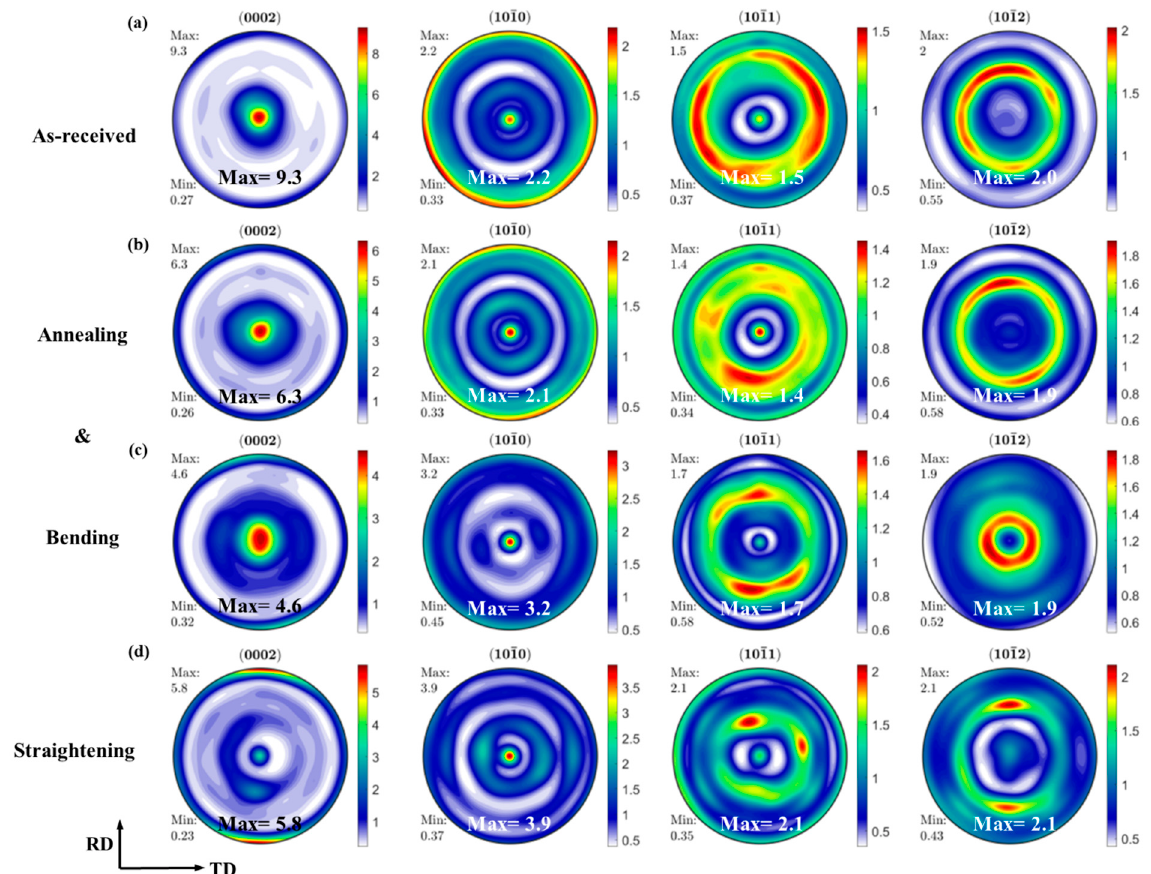
Figure 3. Macrotexture: ( a ) as-received sample, ( b ) the sample after annealing, ( c ) the sample after bending, and ( d ) the sample after bending and straightening.